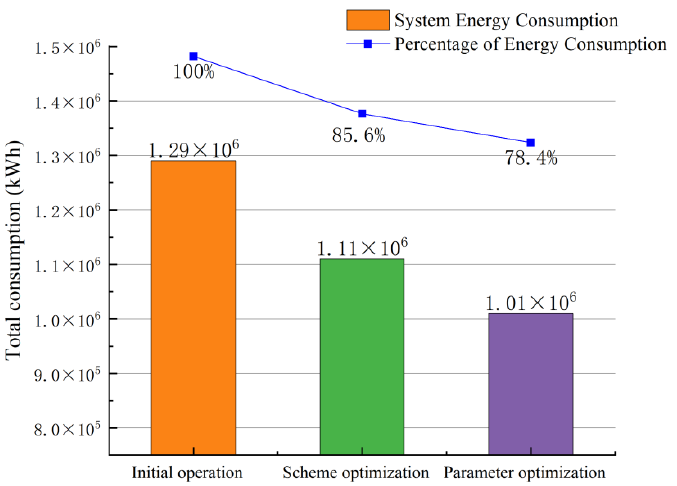
Figure 13. Total energy consumption under different optimized